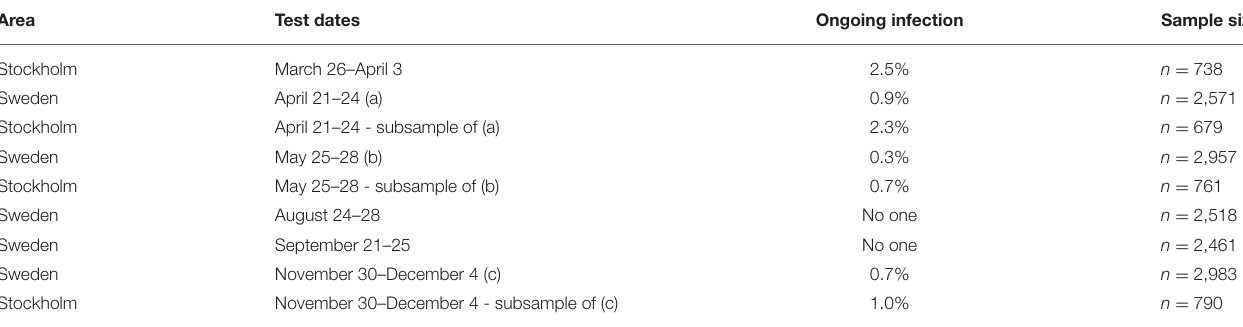
TABLE 1 | Results from the PHA’s population tests to monitor the spread of COVID-19 during 2020. Area Test